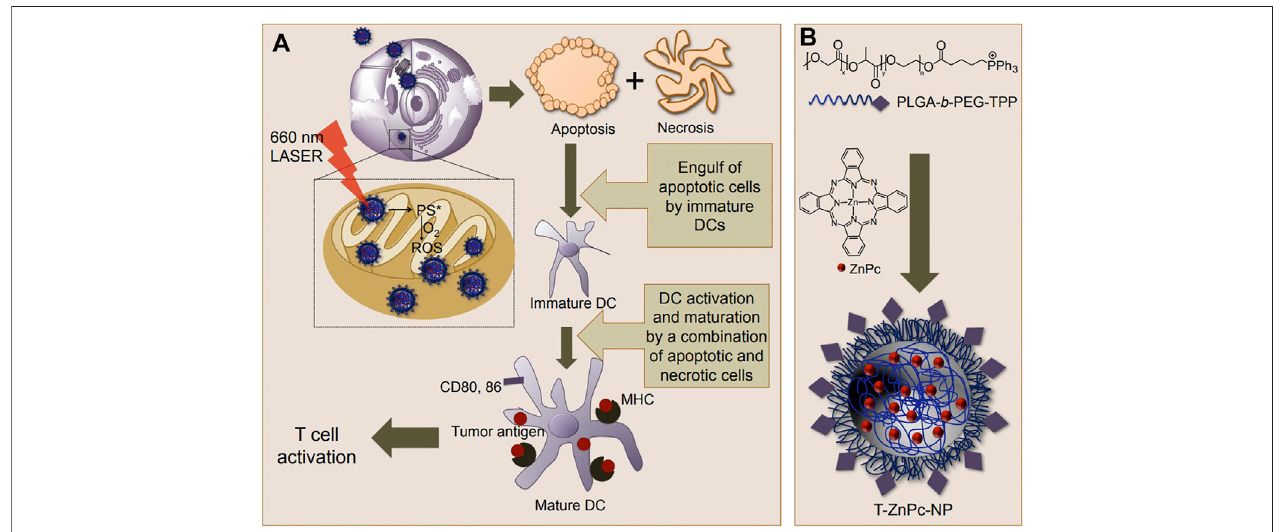
FIGURE 1 | (A) Action of mitochondria-targeted nanoparticles (NPs) upon light activation inside mitochondria to produce ROS, which causes cell death and T-cell activation; (B) Synthesis ofT-ZnPc-NPs using a nanoprecipitation method. Reproduced from ref (Marrache et al., 2013) with permission from Copyright 2013American Chemical